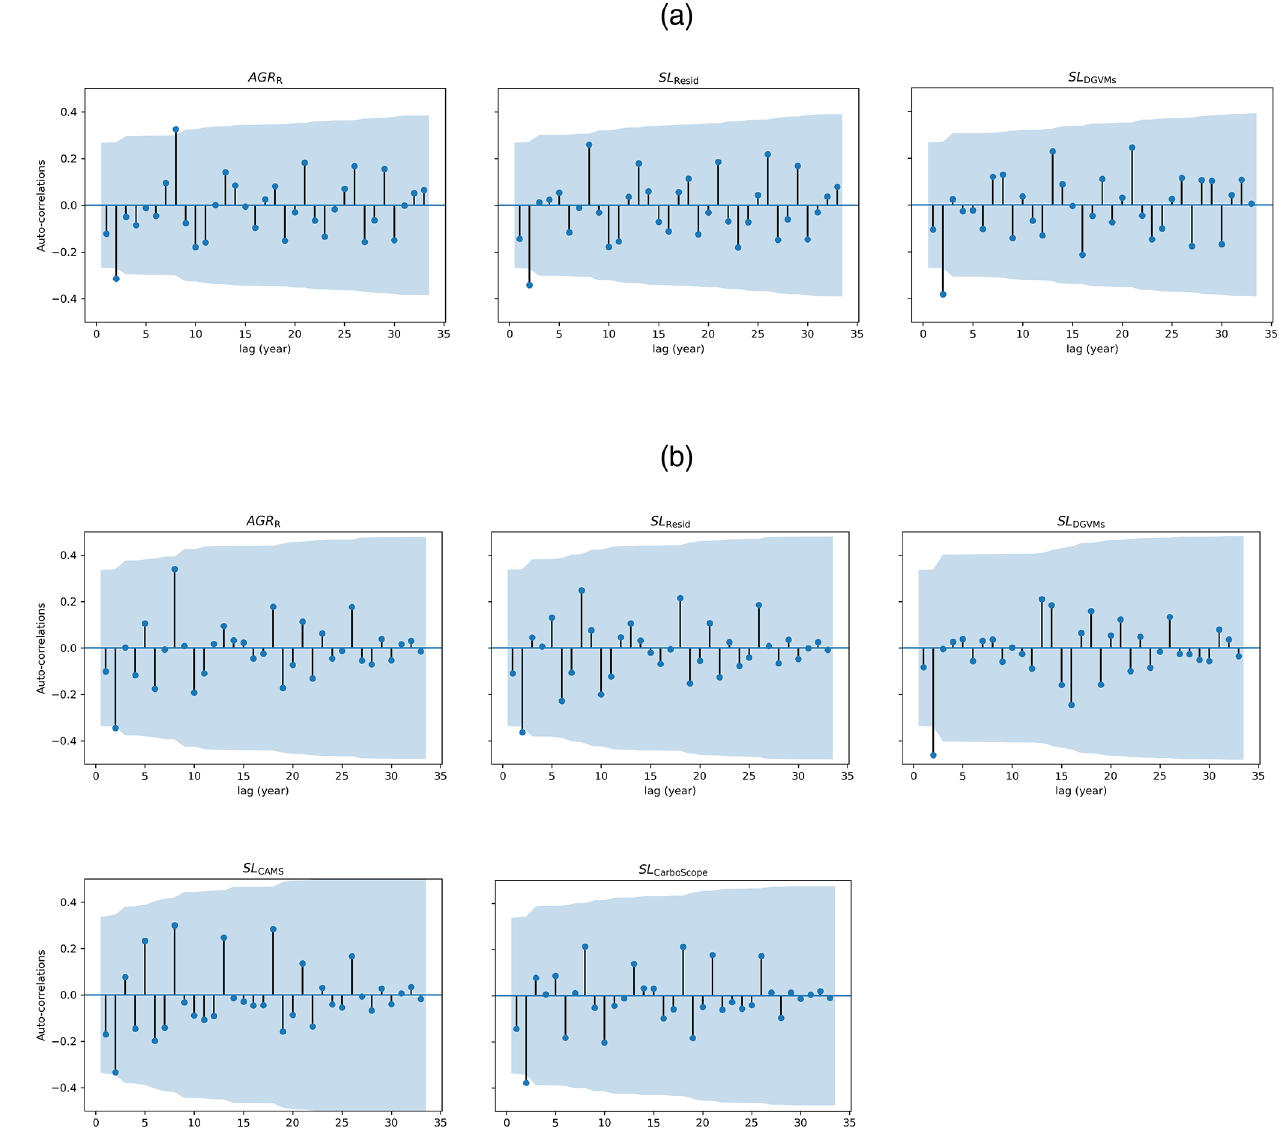
Figure A3. Time series autocorrelations of pre-treated CO 2 time series in the period (a) 1959–2017 for AGR R , SL Resid , and SL DGVMs . (b) 1980–2017 included two more inversions: SL CAMS and SL CarboScope . The shaded areas are the 95% confidence interval of the calculated autocorrelation under different